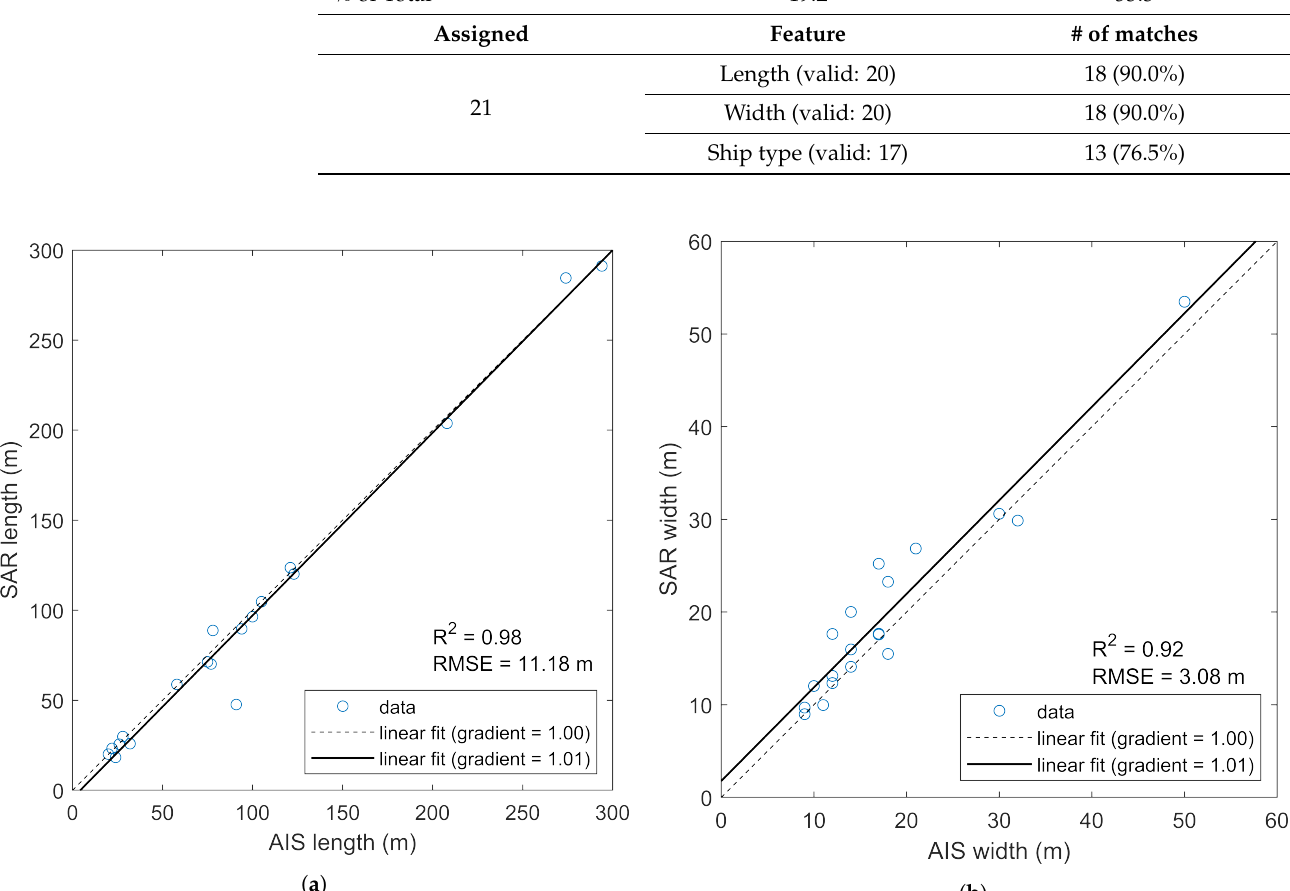
Figure 18. The Solent estimated SAR ( a ) length and ( b ) width against reported AIS for each